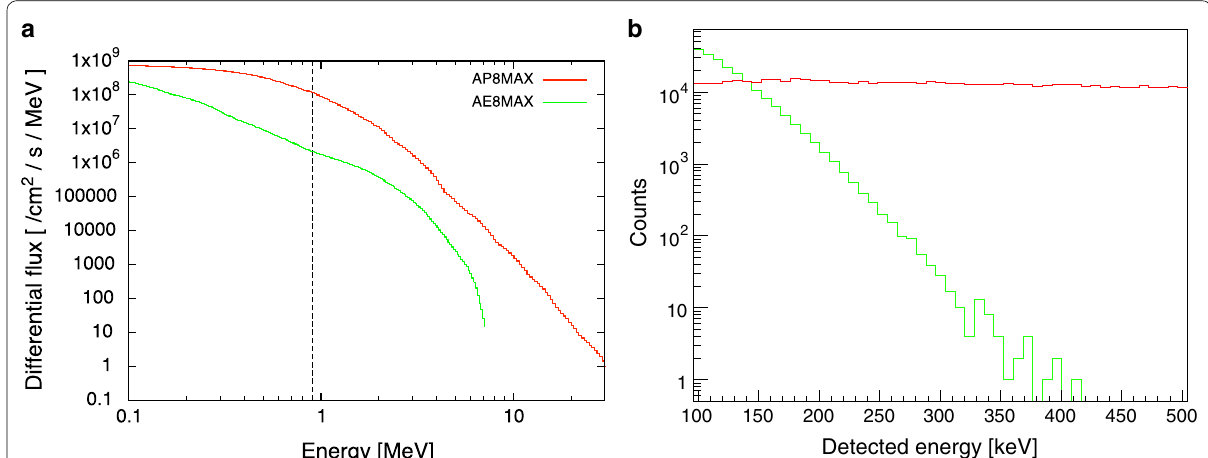
3 based on AE8 MAX and AP8 MAX models; b detected energy spectra in first layer of =